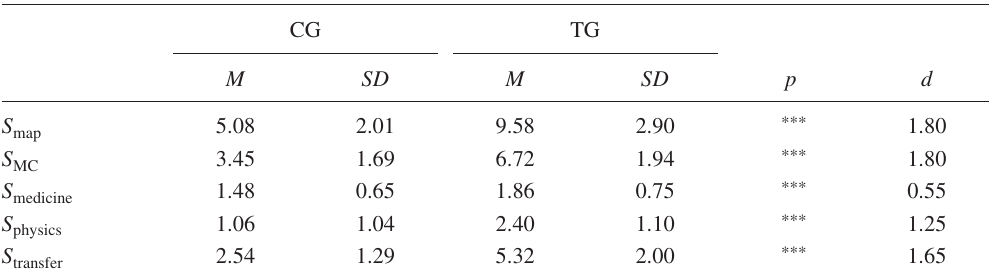
TABLE IX. Means M and standard deviations SD of different scores for control group (cid:1) N =287 (cid:2) and treatment group (cid:1) N =287 (cid:2) with level of significance (cid:1) (cid:1)(cid:1)(cid:1) p (cid:7) .001 (cid:2) and Cohen’s d .